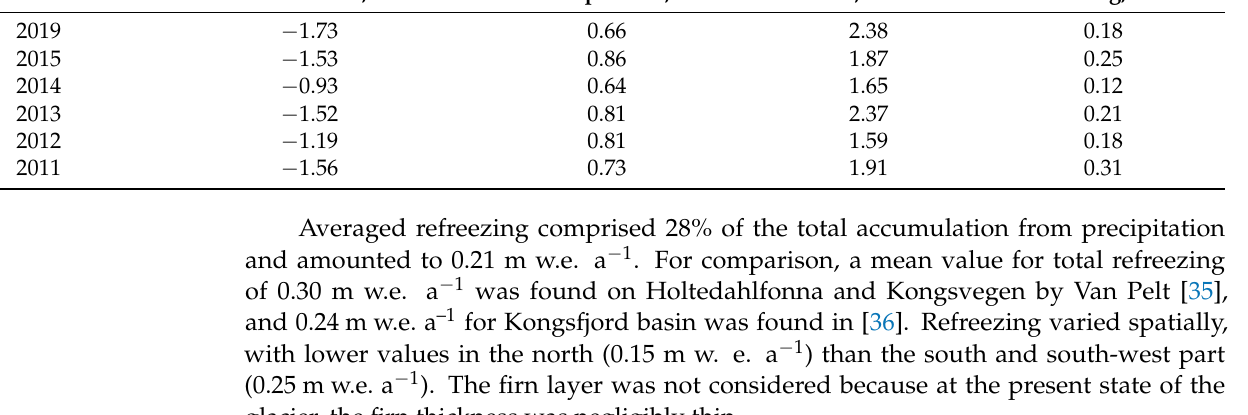
Figure 9. Relation between observed stake measurements and modelled melt after the calibration of A-Melt model. Table 5. The mass balance, solid precipitation amount, melt and refreezing of Austre Grønfjordbreen modelled for 4 balance years. Balance Year Net Mass Balance, m w.e. Solid Precipitation, m w.e. Melt, m w.e. Refreezing, m